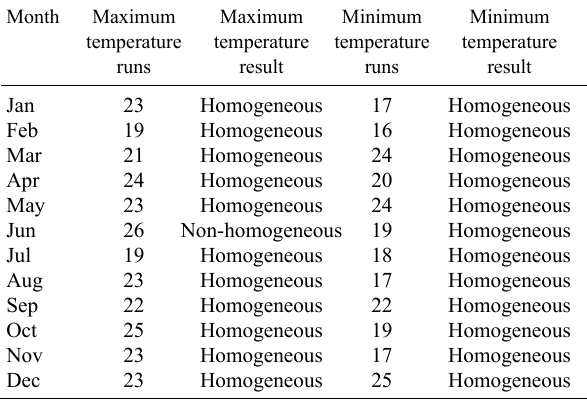
Results of run test to determine homogeneity of maximum